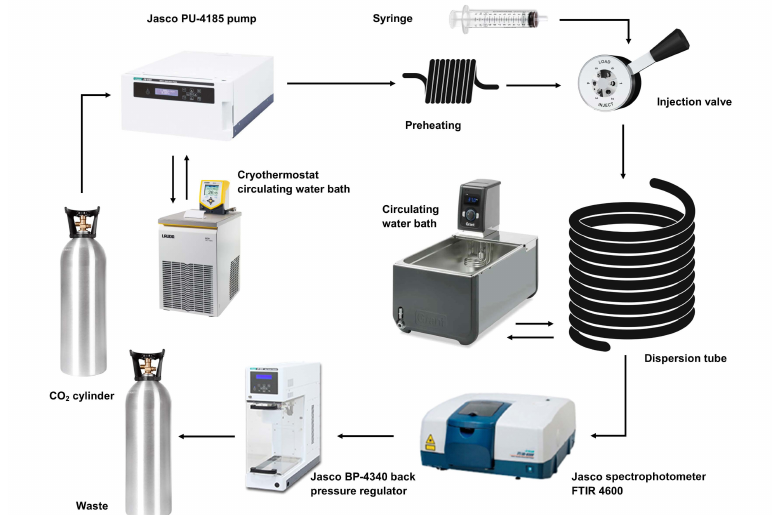
Figure 4. Schematic representation of the high-pressure Taylor dispersion